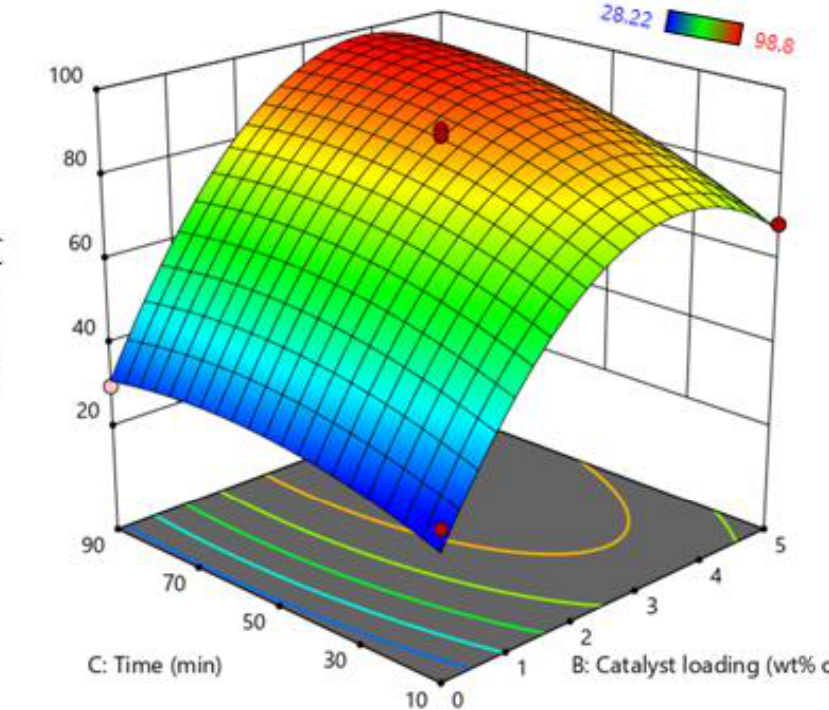
Figure 5. Interactive effect of reaction time and catalyst loading .